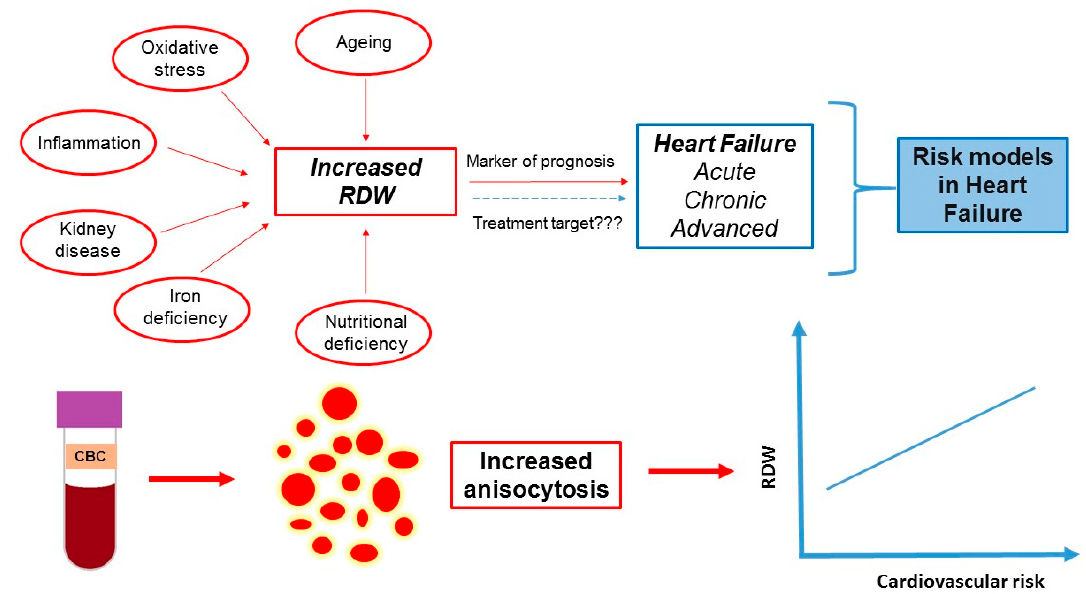
Figure 3. The role of RDW in heart failure. RDW is a simple parameter derived from the complete blood count (CBC) and expresses the variability in red blood cell size (anisocytosis). RDW has been used as a marker of prognosis in acute, chronic and advanced heart failure either as a sole variable or as a variable included in risk models. Higher RDW has been associated with increased risk of death and/or re-hospitalization. Several (patho)physiological mechanisms such as ageing, oxidative stress, inflammation, kidney disease, iron deficiency and nutritional deficiency have been implicated in the reported RDW increase in patients with heart failure. Whether or not RDW can be used as a treatment target remains to be elucidated in future studies.